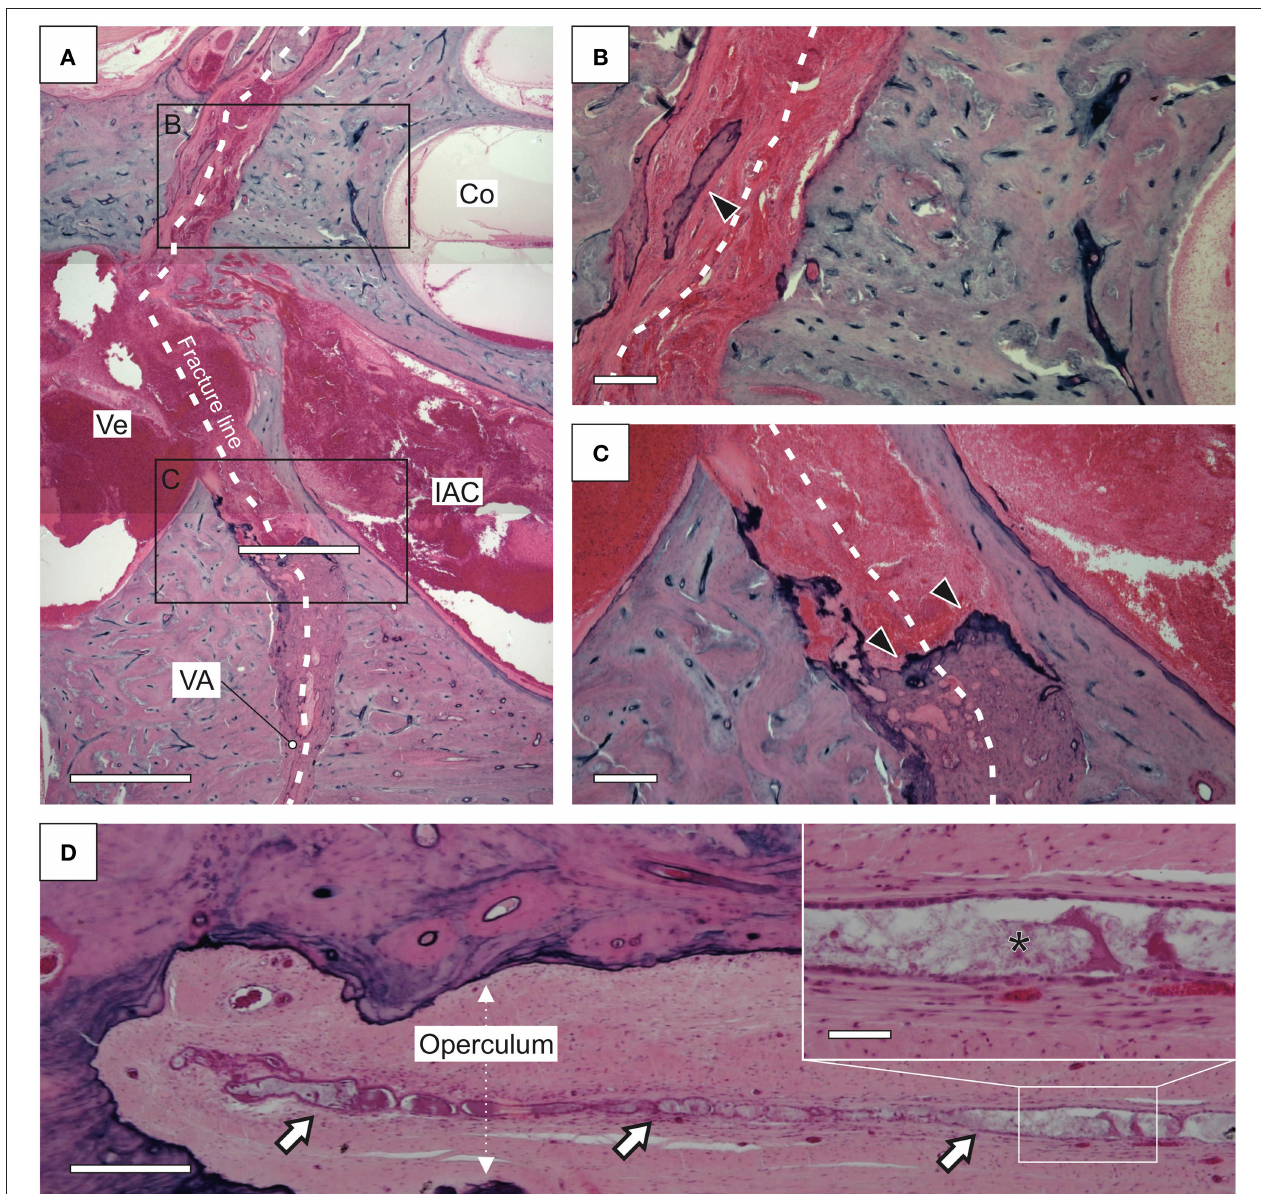
FIGURE 3 | Histopathology of a temporal bone fracture that affected the vestibular aqueduct (VA) in a postmortem case [same as “case 1” in (7)]. The patient died 33 years after the trauma. (A–C) Overview (A) and details (B,C) of the fracture line (white dotted line) that spared the cochlea (Co) and coursed through the vestibule (Ve) into the VA. In close proximity to the labyrinth spaces of the Co and the Ve, the fracture cleft is filled only with fibrous tissue, and only minor bony fracture healing [new bone formation; arrowhead in (B) ] was observed. In the VA, at an increased distance from the Co and the Ve, the fracture cleft became entirely obliterated with new callus bone [arrows in (C) ]. (D) The endolymphatic sac distal to the operculum (extraosseous portion) demonstrated a normal epithelium (IAC, internal auditory canal). The inner ear presented cochleosaccular endolymphatic hydrops (data not shown). Scale bars: (A,D) , 500 µ m; ( B,C , inset in D ), 100 µ m. Courtesy of the Massachusetts Eye and Ear Infirmary (MEEI; Boston, MA,